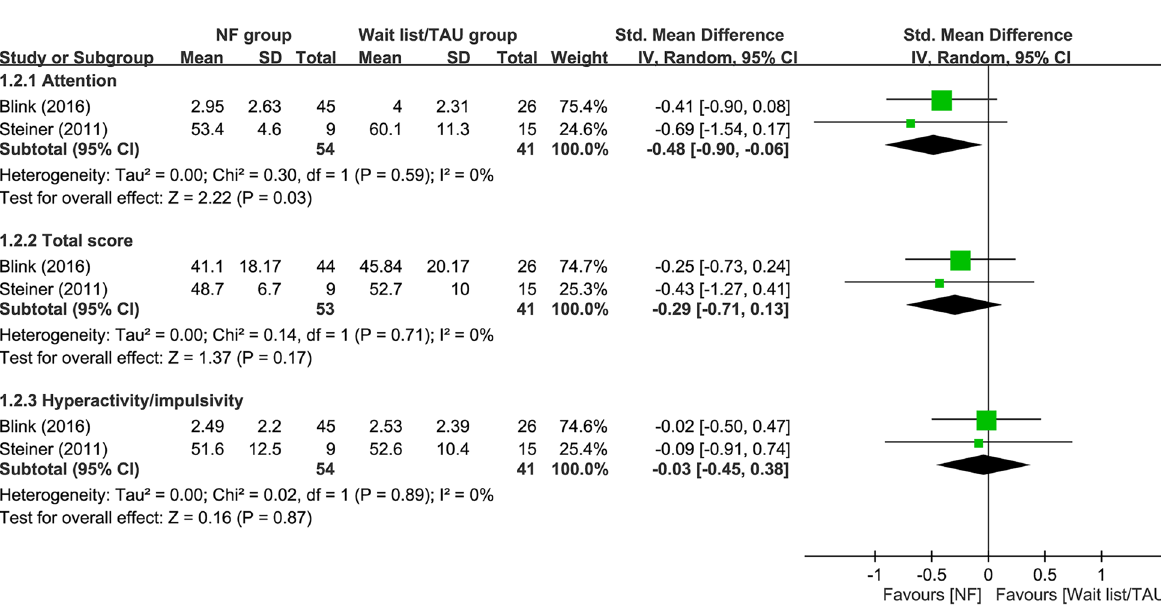
Figure 5. Forest plot for comparing symptoms of attention-deficit hyperactivity disorder between EEG-NF and waitlist/TAU groups. CI, confidence interval; IV, inverse variance; Std,